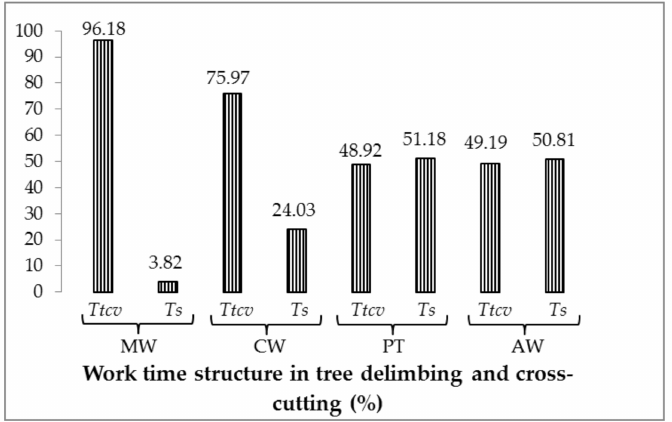
Figure 2. Work time structure according to operations: MW—main work time; CW—complementary work time; PT—preparatory time; AW—ancillary work time; Ttcv—work time consumed for delimbing; Ts—work time consumed for tree